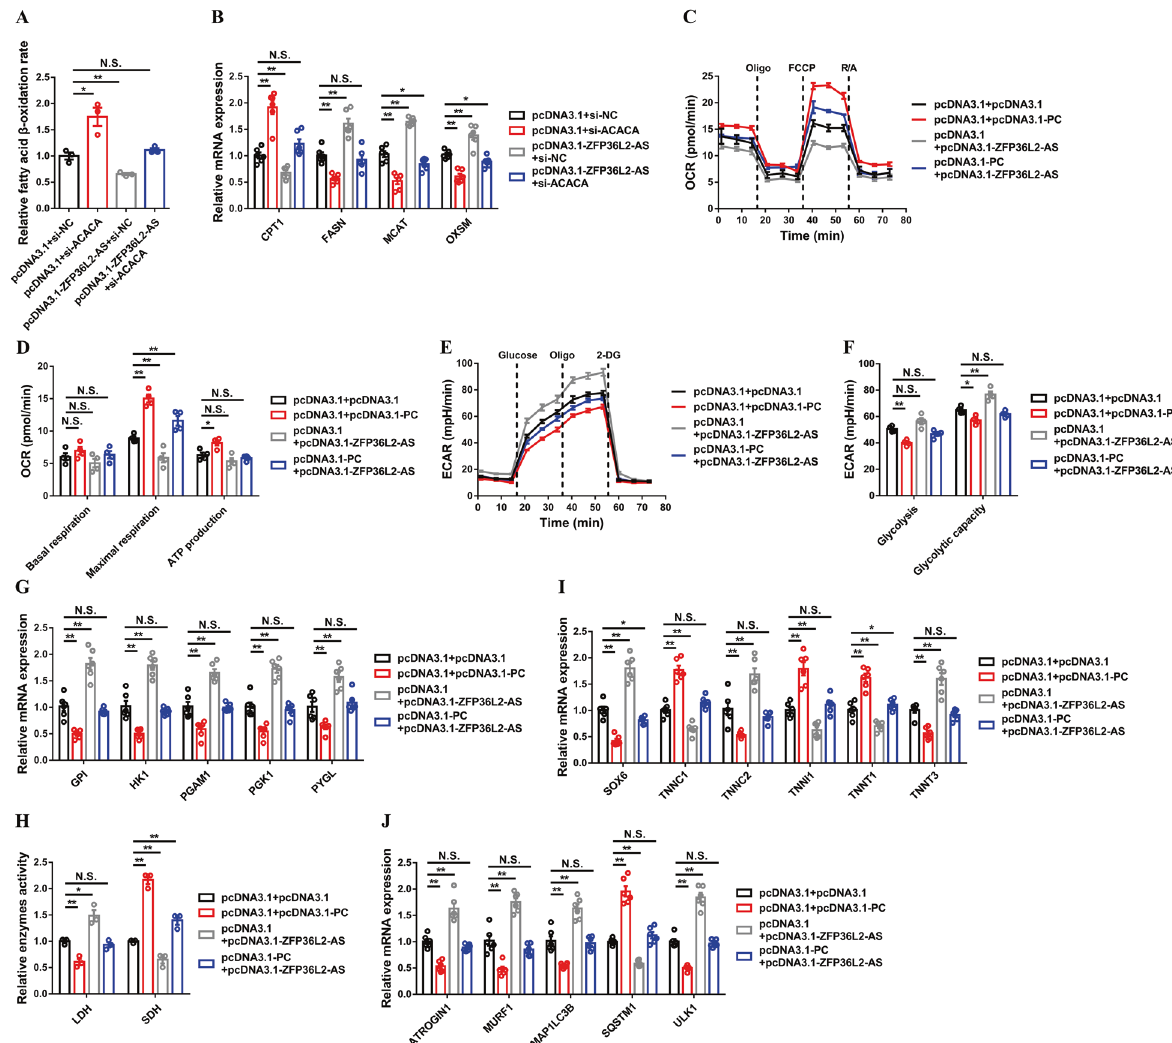
respiration, maximal respiration and ATP production ( D ), ECAR ( E ), glycolysis and glycolytic capacity ( F ), relative mRNA expression levels of glycogenolytic and glycolytic genes ( G ), relative enzymes activity of LDH and SDH ( H ), relative mRNA expression levels of several fast-/slow- twitch myo fi ber genes ( I ), and relative mRNA expression of the atrophy and autophagy-related genes ( J ) induced by the listed nucleic acids in CPMs. Results are shown as mean ± SEM. In all panels, statistical signi fi cance of differences between means was assessed using ANOVA followed by Dunnett ’ s test. (* P < 0.05; ** P < 0.01; N.S. no signi fi cant